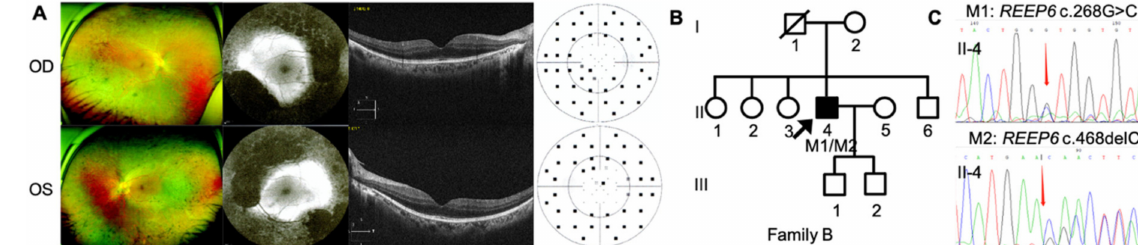
Figure 2. Phenotype and genotype of family B. Heterozygous variants of REEP6 c.268G>C and c.468delC were found in this family. ( A ) Clinical findings of proband B: II-4 including fundus photography, AF and SS-OCT images. ( B ) Pedigree of family B. Black arrows represented the proband. ( C ) Sanger sequencing confirmation of proband B: II-4.